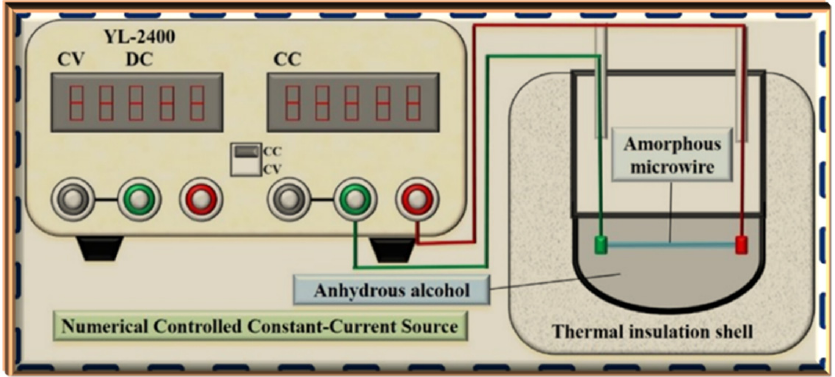
Figure 1. Schematic illustration of the AJA process with insulation material and the microwire surrounded by the anhydrous ethanol, during annealing process.